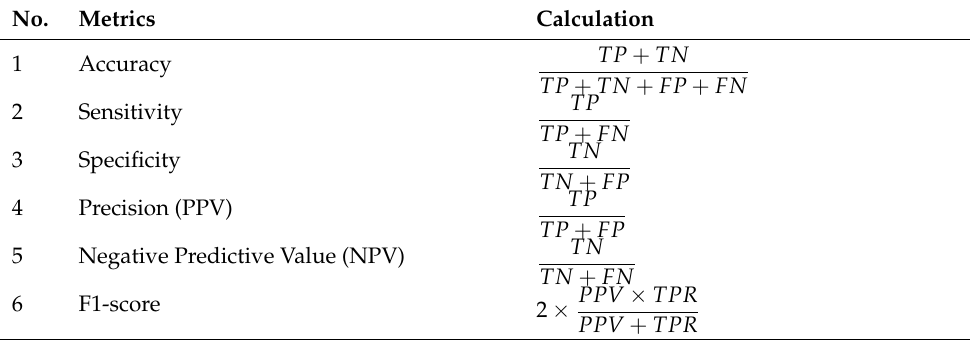
Table 5. Performance metrics used in CNN